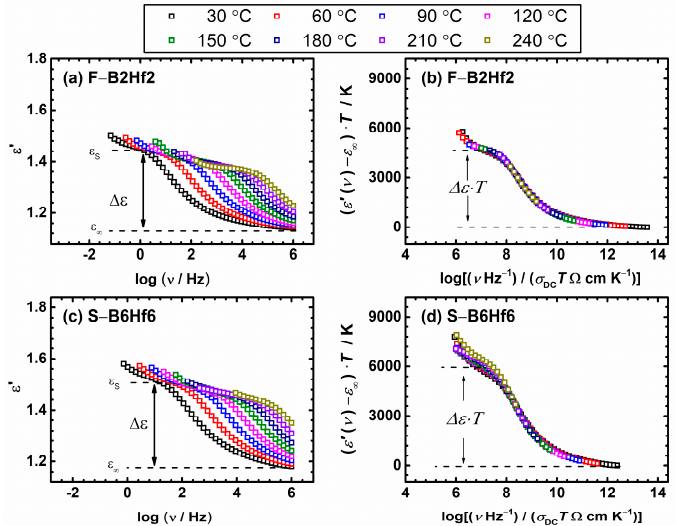
Figure 7. ( a , c ) Permittivity spectra at different temperatures and ( b , d ) their scaled representation obtained using the Summerfield scaling procedure for the sample F − B2Hf2 and S − B6Hf6.